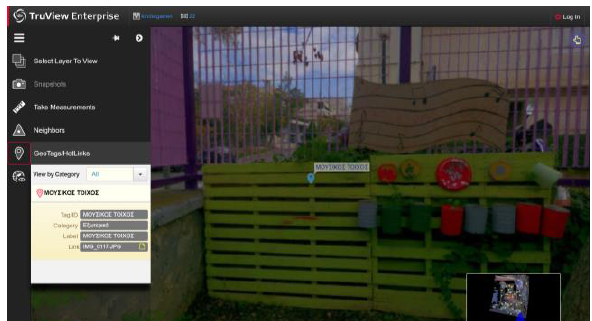
Fig. 7. Example of a geo-tagged object (music wall)